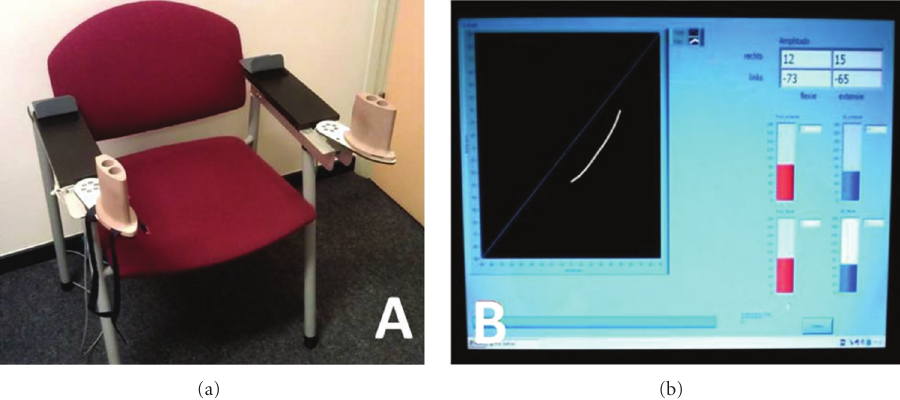
Figure 1: Modified BATRAC apparatus. (a) Manipulanda with handgrips. (b) Feedback, with Lissajous plane on the left (movements of left hand plotted against those of the right hand) and feedback regarding amplitudes and relative phase (and its variability) on the right. Reprinted with permission.